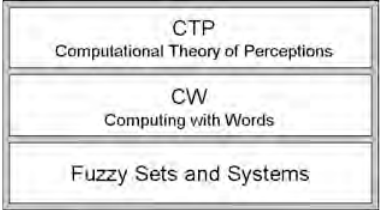
Fig. 5. Zadeh’s hierarchical stack of SC